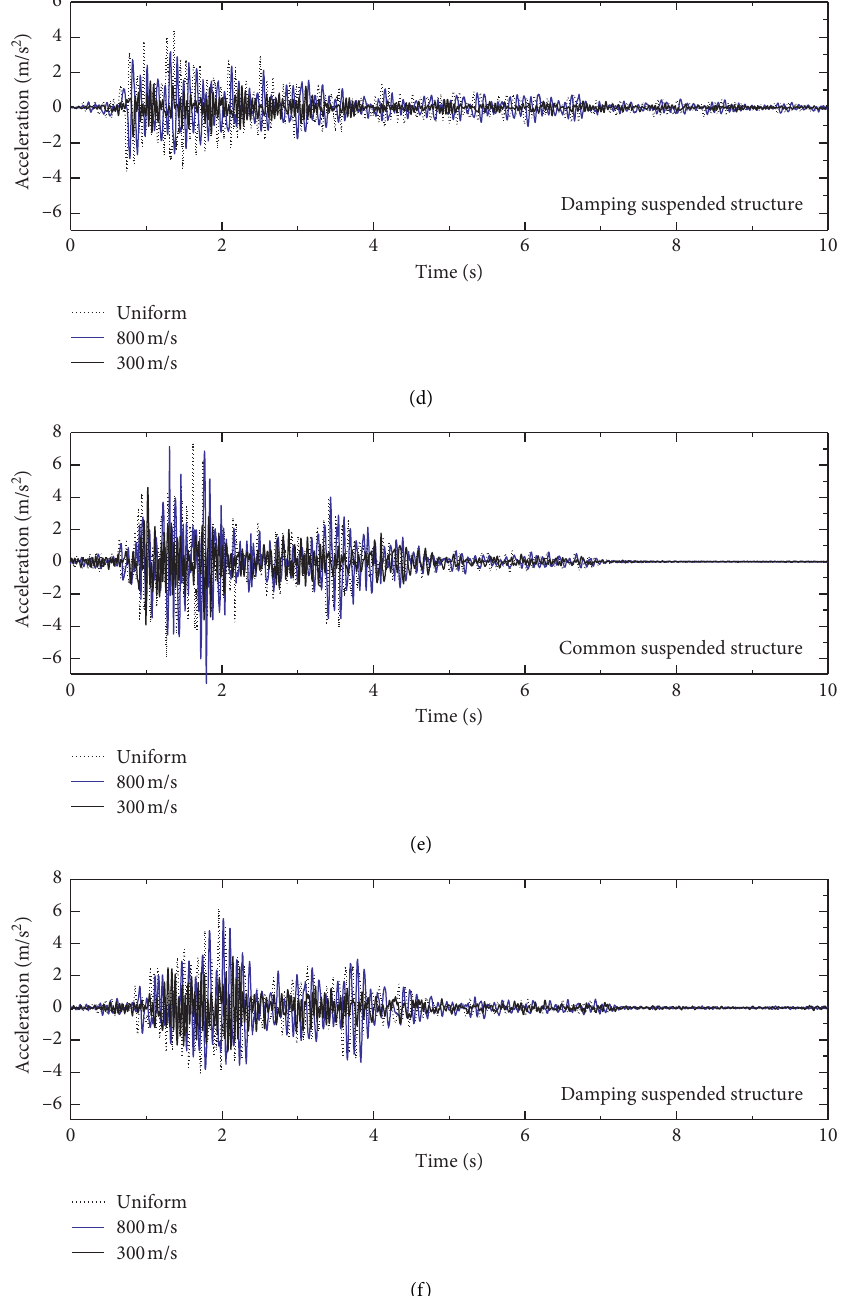
Figure 8: Acceleration time-history curves at the top of primary structure under 9 frequent earthquakes. (a) Acceleration time history of common suspended structure under El Centro. (b) Acceleration time history of damping suspended structure under El Centro. (c) Acceleration time history of common suspended structure under Taft. (d) Acceleration time history of damping suspended structure under Taft. (e) Acceleration time history of common suspended structure under the artificial wave. (f) Acceleration time history of damping suspended structure under the artificial